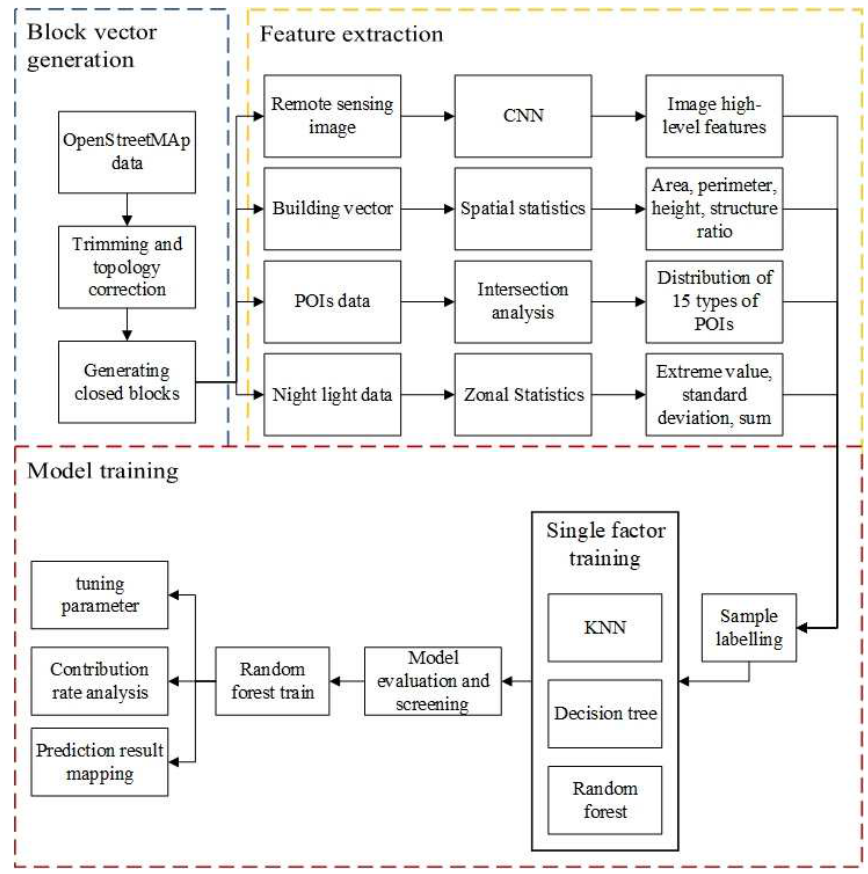
Figure 3. Technical framework.